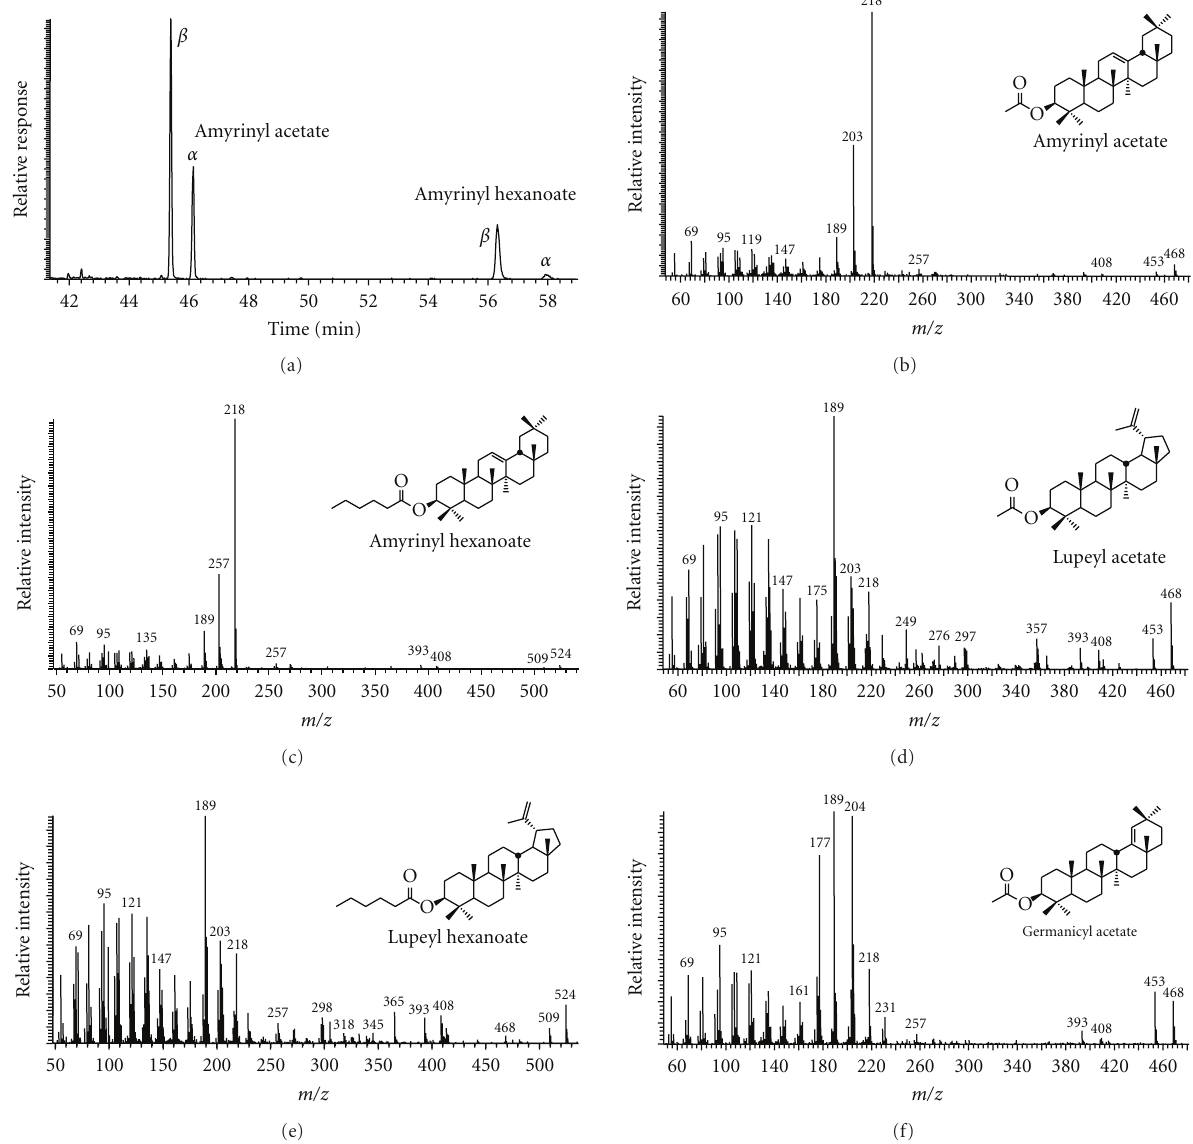
Figure 3: Examples of GC-MS data for triterpenoid esters in sediment extracts: (a) m/z 218 mass fragmentogram for amyrinyl esters, (b) mass spectrum of β -amyrinyl acetate, (c) mass spectrum of β -amyrinyl hexanoate, (d) mass spectrum of lupeyl acetate, (e) mass spectrum of lupeyl hexanoate, and (f) mass spectrum of germanicyl